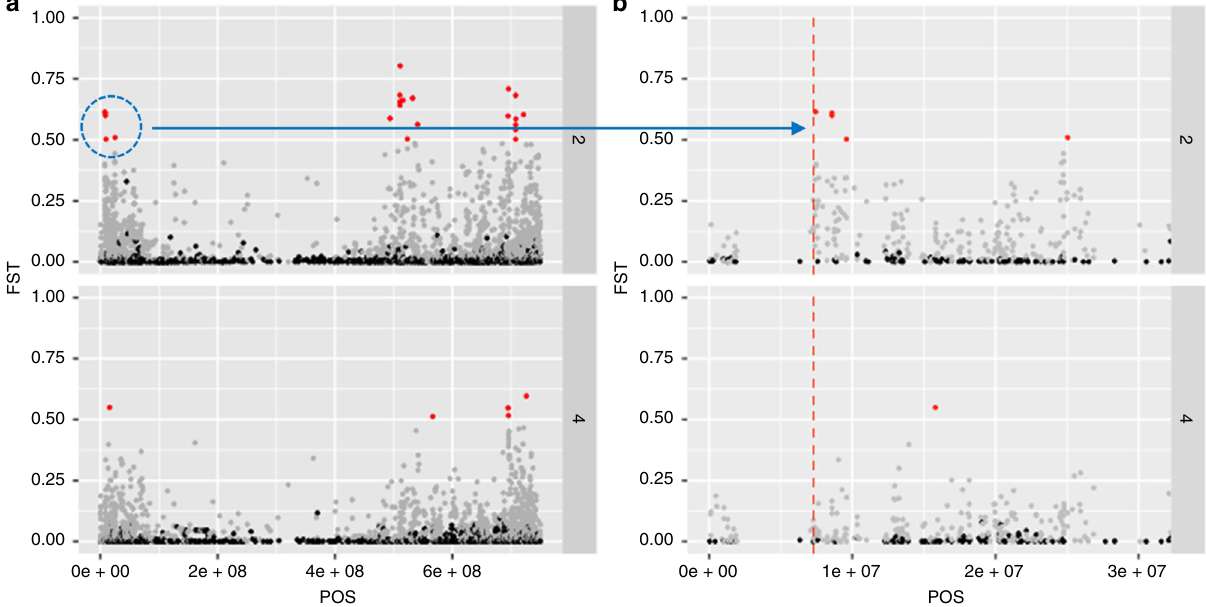
Fig. 4 Analysis of F ST values on a variant per variant basis across the genome highlights areas of positive selection. a F ST analysis of the complete chromosome 3A in cluster 2 (upper half) and 4 (lower half of fi gures); b zoom in of chromosome 3A positioning of the preharvest sprouting gene TaMFT .